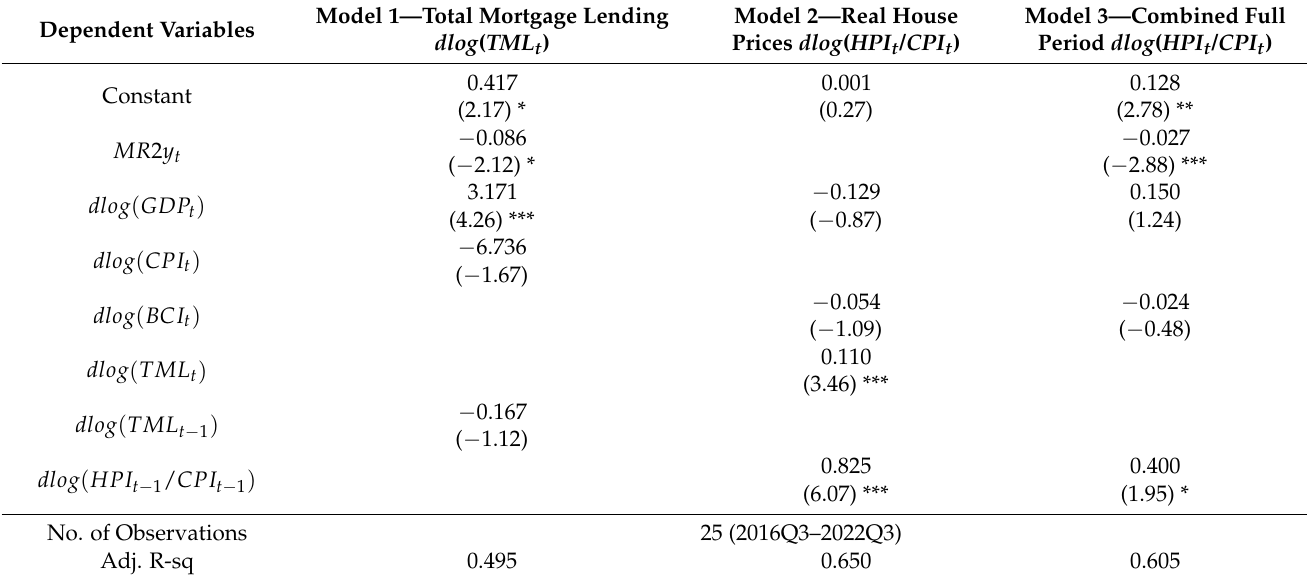
Table 3. Results of the regression models.